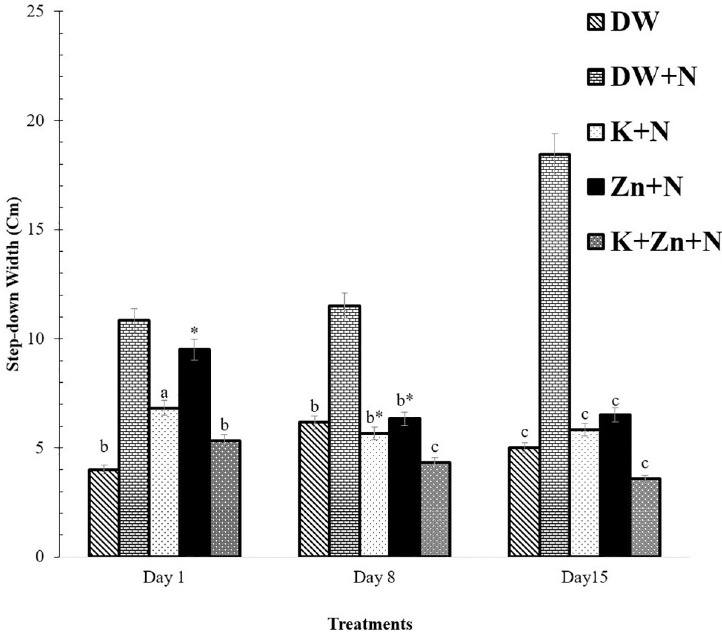
Fig 5. Effect of kaempferol and zinc on motor strength (fore-paw grip) in Wistar rats exposed to noise stress (Mean ± SEM, n = 6). The time spent by each rat before releasing its grip was recorded in seconds. a P < 0.05, b P < 0.01, is significantly different compared to control group (DW+N). DW, Deionized water; K, Kaempferol; Zn, Zinc gluconate; N, Noise.